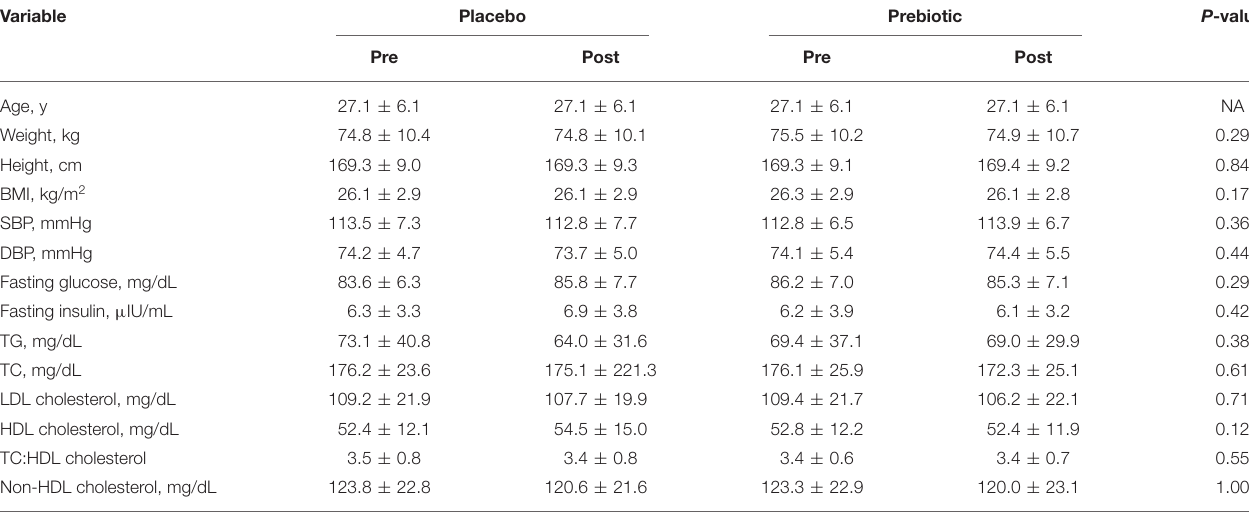
TABLE 1 | Participant anthropometric and cardiometabolic characteristics pre- and post-treatment on placebo and prebiotic fiber*.